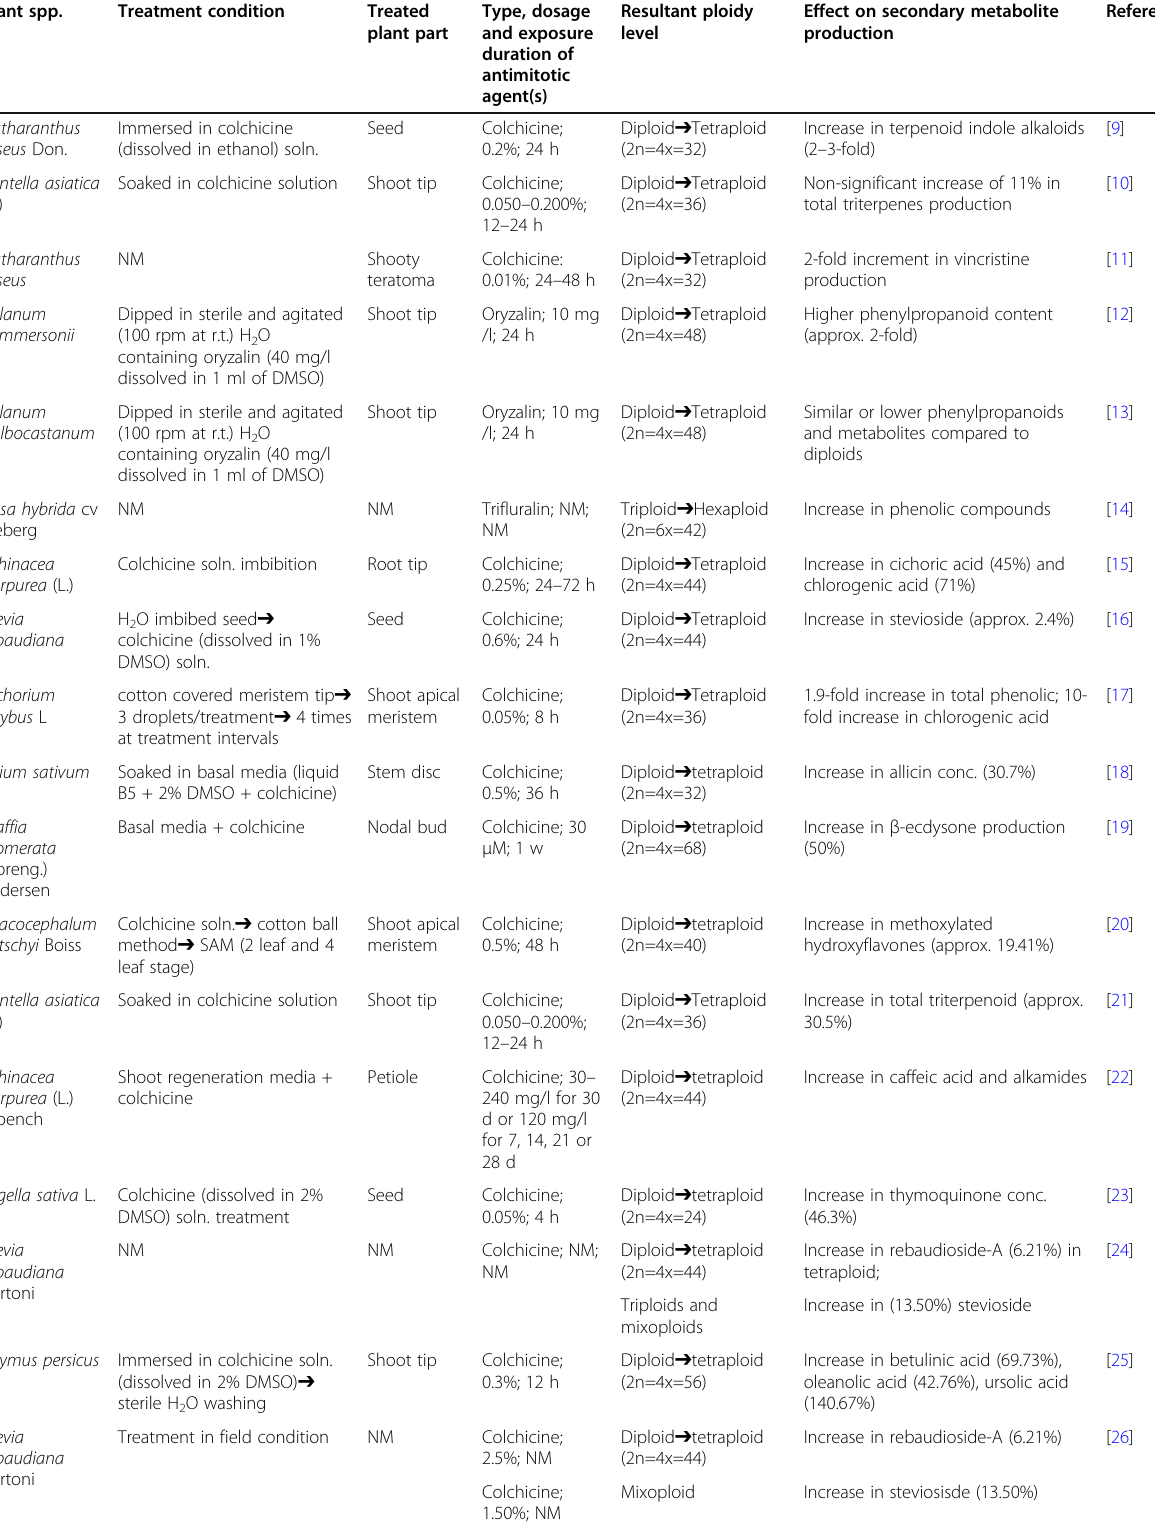
Table 1 Antimitotic agent(s) and their influence on autopolyploidization and subsequent secondary metabolites production (arranged in chronological order) Plant